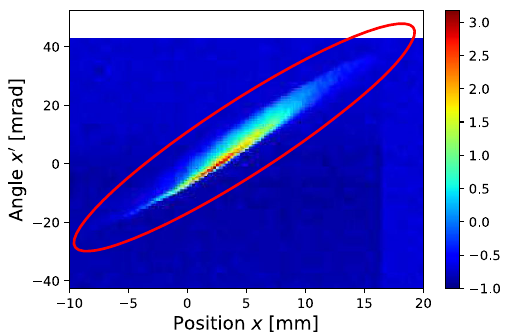
FIG. 19. Nonzero data points after background